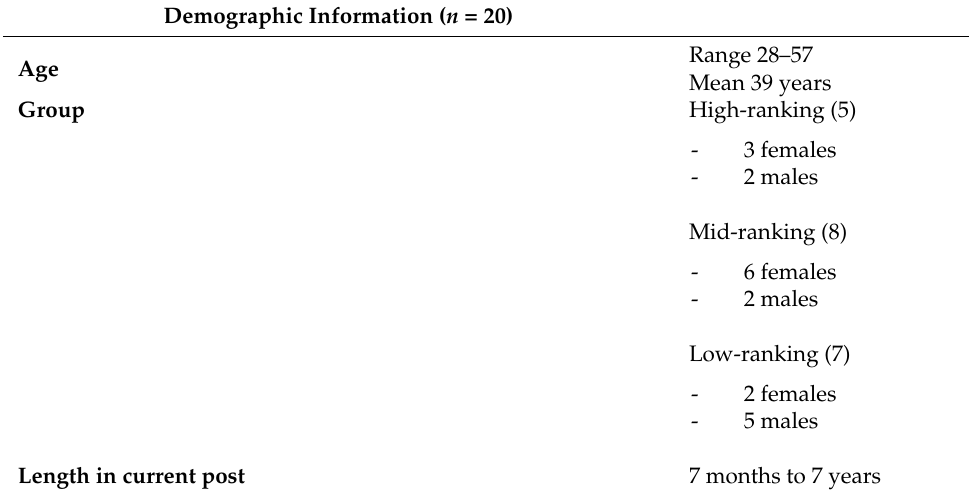
Table 1. Summary of participants